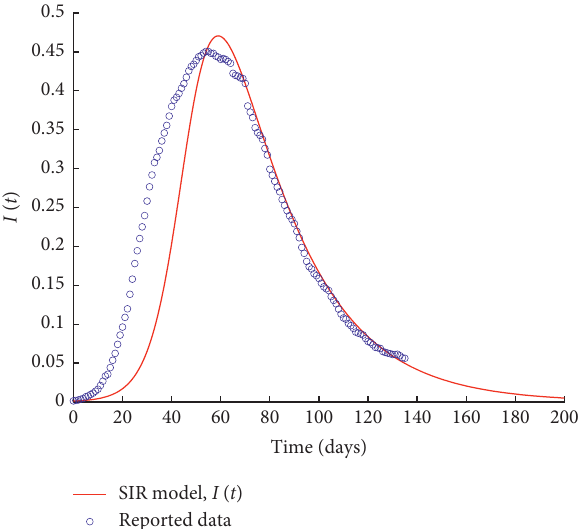
Figure 4: Evolution of the Malthusian function, r(t), parameter- izing the time-varying logistic equation.